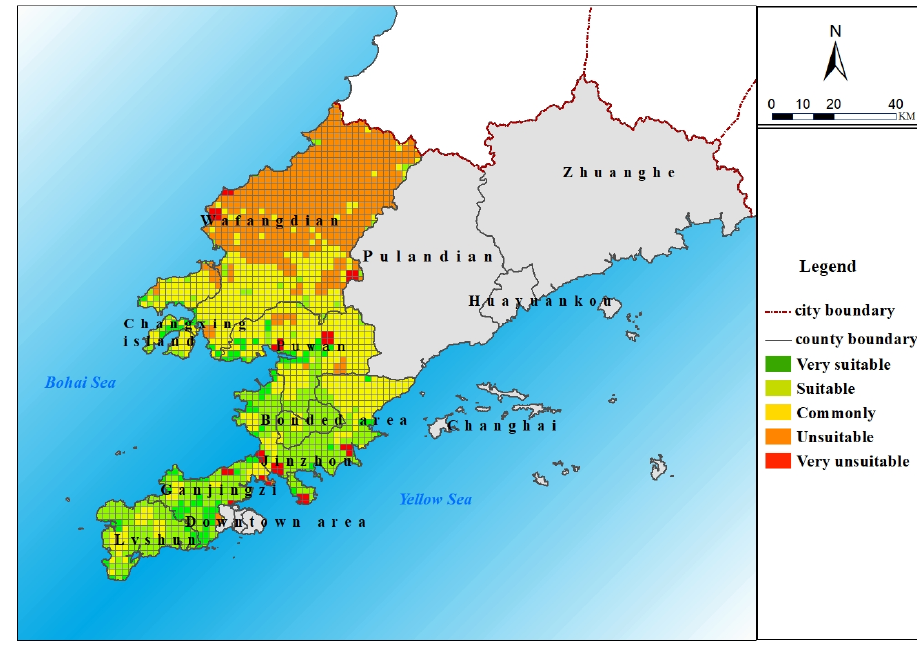
Figure 2. Wind farm suitability area based on Shapley value.